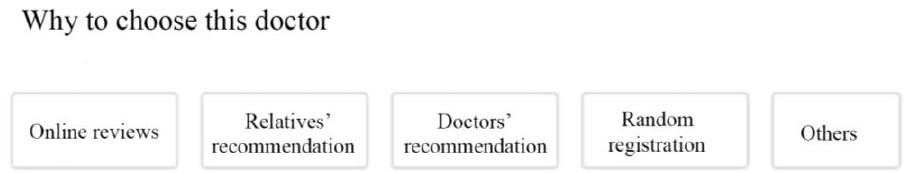
Figure 2. Doctor patient review section.